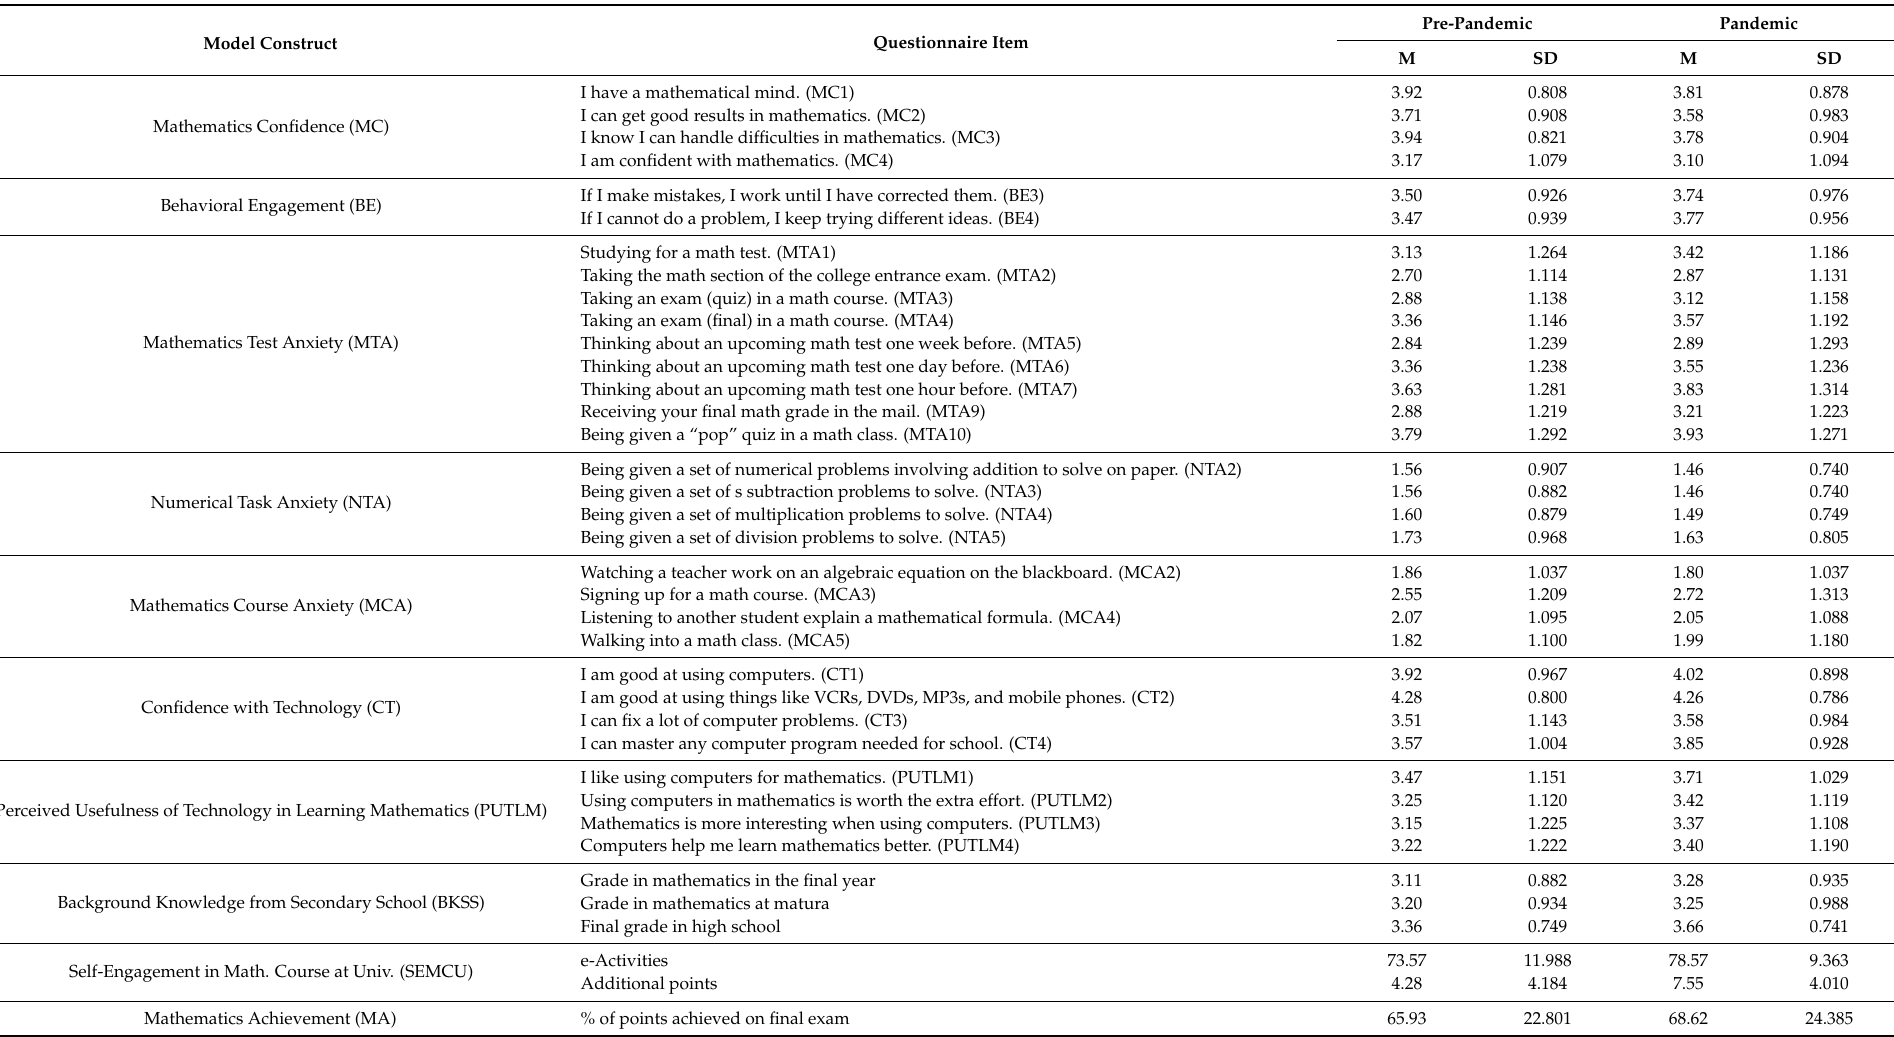
Table 3. Descriptive statistics of questionnaire